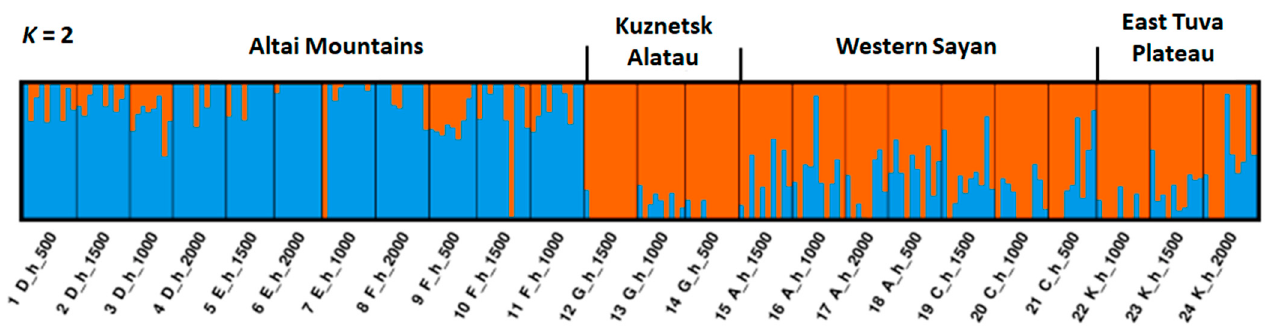
Figure 7. Graphs displaying the results of analysis of probable number of clusters K . Cross-valida- tion prediction error, log likelihood and Δ K values for each K based on all 25,143 SNPs ( A – C ), 761 neutral SNPs ( D – F ) and 550 adaptive SNPs ( G – I ).